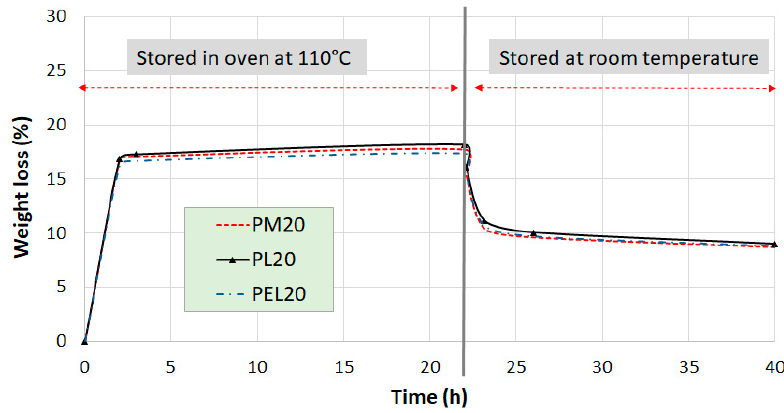
Figure 7. Weight losses of peat during drying (weight loss compared to the as-received sample) [24].